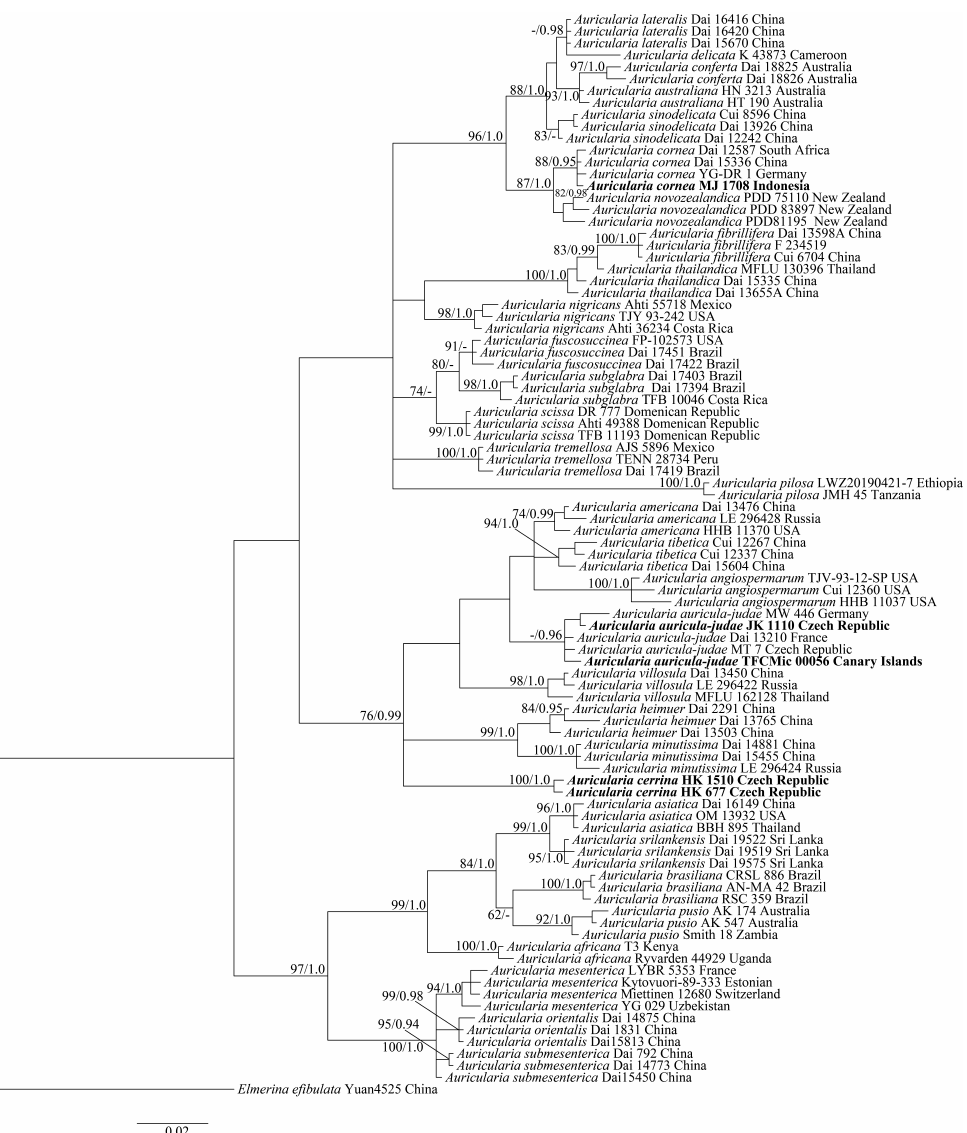
Figure 2. Bayesian phylogenetic tree (ITS region) of the selected specimens of Auricularia . Sequences generated in this study are in bold. Maximum likelihood bootstrap support and Bayesian posterior probability are shown.